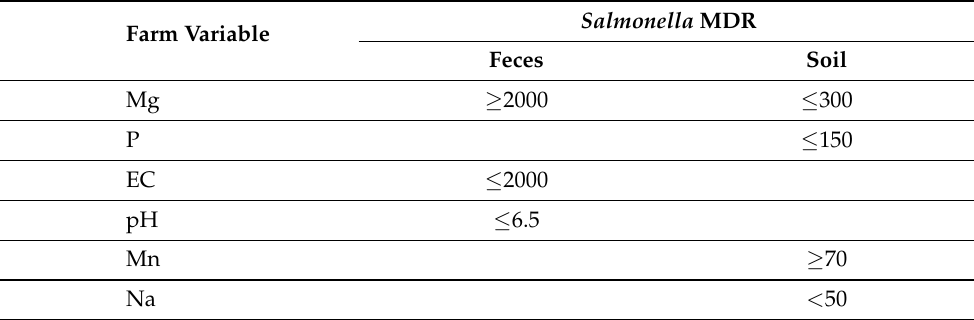
Table 7. Pre-harvest feature value recommendations for reducing Salmonella multidrug resistance. Farm